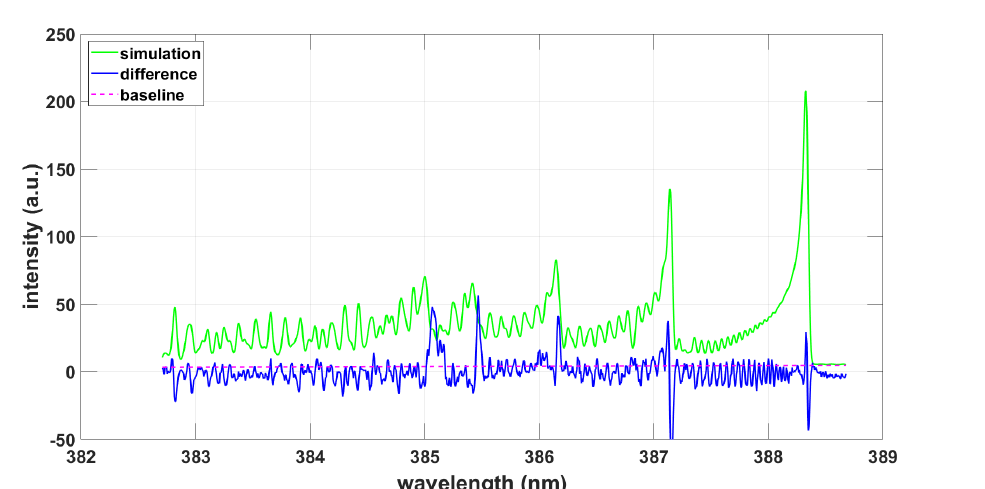
Figure 3. Simulation using ExoMol data and the NMT program, T = 8150 K, ∆ λ = 0.038